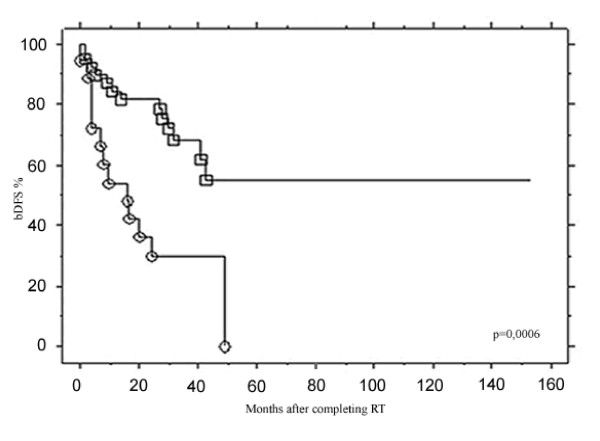
Comparison of bDFS after the end of RT according to 1 ng/ml preRT PSA threshold. PSA ≥1 ng/ml(○) vs. <1 ng/ml(□).